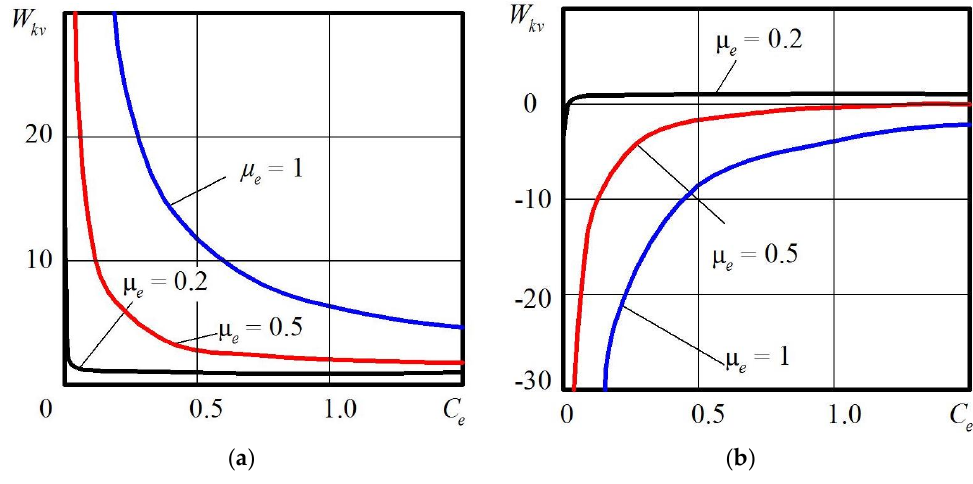
Figure 3. Function graphs W kv = W kv f ( C e ) by: ( a ) − ξ e = 0.9; ( b ) − ξ e = 1.1.